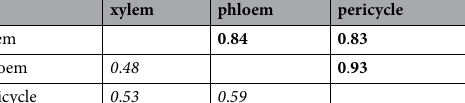
Table 2. Comparison of the predicted and the sampled flux distributions for the Li 1 scenario. For the extracted models flux values were randomly sampled for each model. The comparison of the models is conducted only based on the reactions shared between the models in each of the groups of coupled and decoupled to facilitate unbiased comparison of specificity. The comparison is based on the R v -coefficient which ranges between 0 and 1. Similar to the Pearson correlation an R v -coefficient of 1 means high similarity. Bold font indicates values corresponding to the decoupled models, whereas the italic font corresponds to the coupled